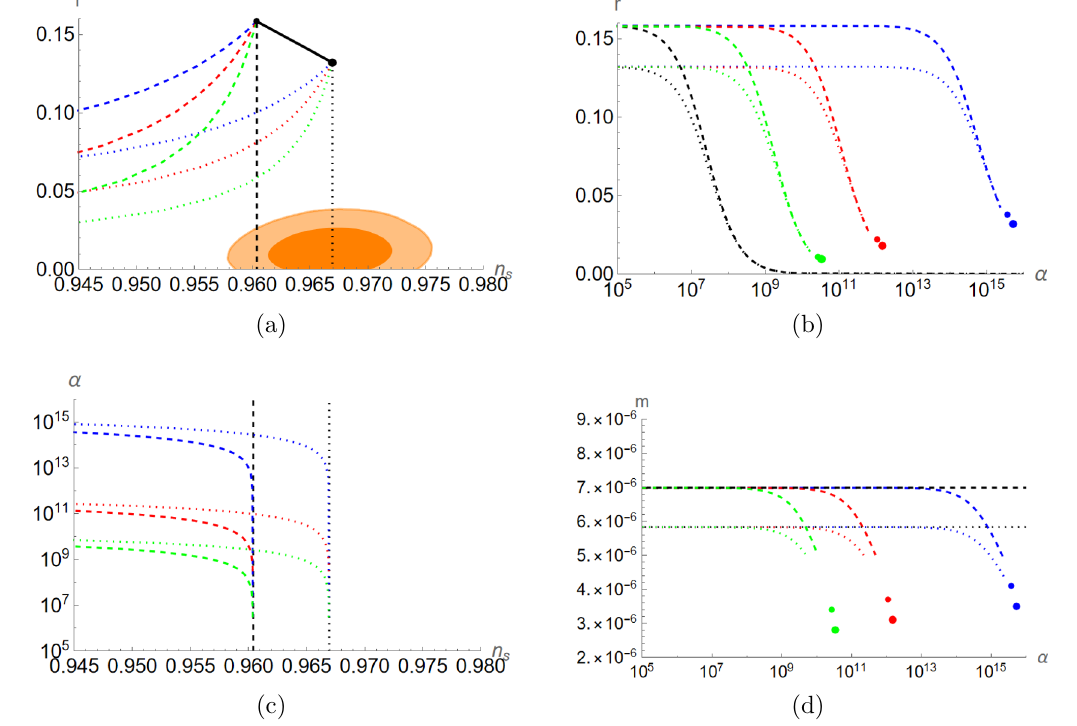
Figure 3. The observables r vs. n s (a), r vs. α (b), α vs. n s (c) and m vs. α (d) for the model in (3.1) with n = 3 (blue), n = 5 / 2 (red), n = 9 / 4 (green) and n = 2 (black) for N e = 50 (dashed) and N e = 60 (dotted). In the same color code, we show the limit values r ¯ α (eq. (3.21)) and m ¯ α (eq. (3.19)) for N e = 50 (small dot) and N e = 60 (large dot). The scalar amplitude A s is fixed to its observed value. The orange areas represent the 1,2 σ allowed regions coming from the latest combination of Planck, BICEP/Keck and BAO data